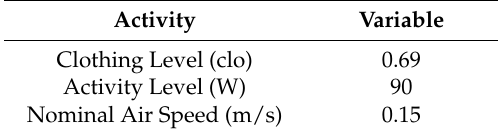
Table 13. Thermal comfort modelling input